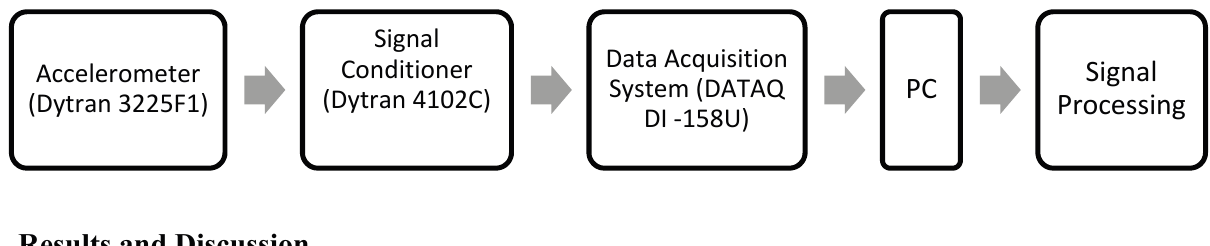
Figure 5. Flowchart showing the process of obtaining the